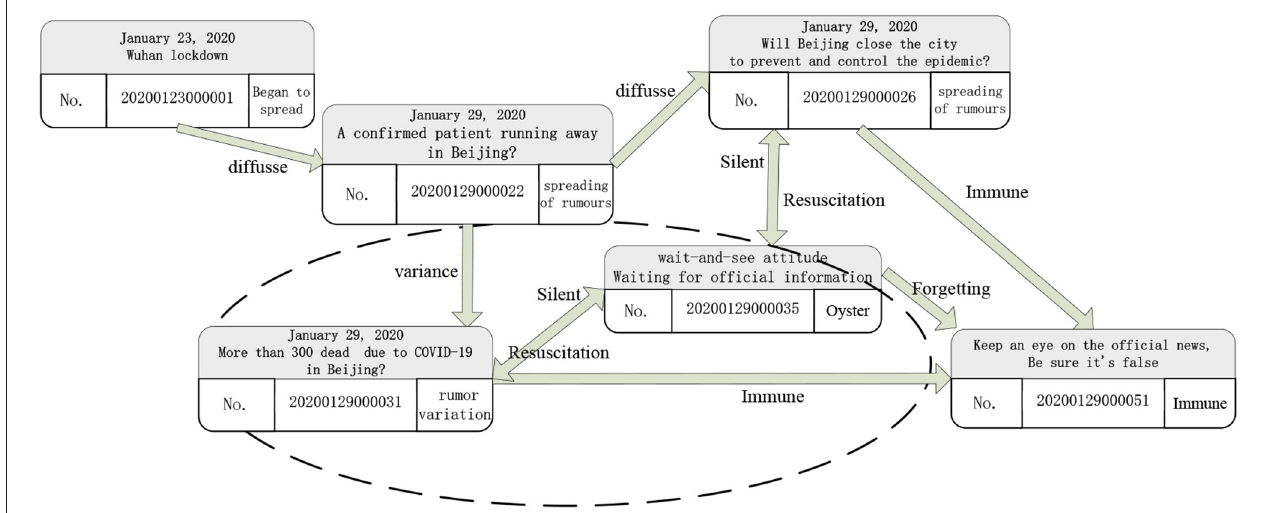
FIGURE 1 | The spread of “new crown epidemic” rumors (number is